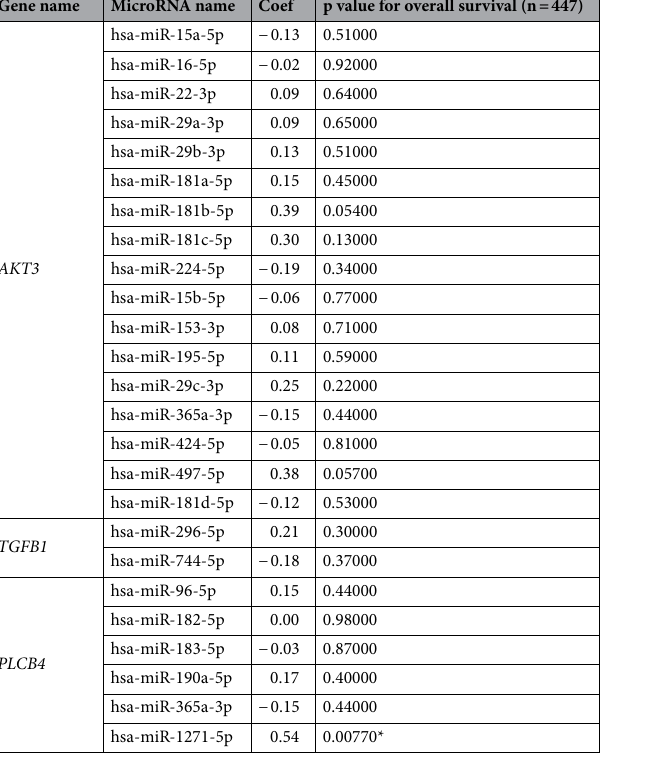
Table 4. Survival analysis of miRNA that targets candidate genes. * p <